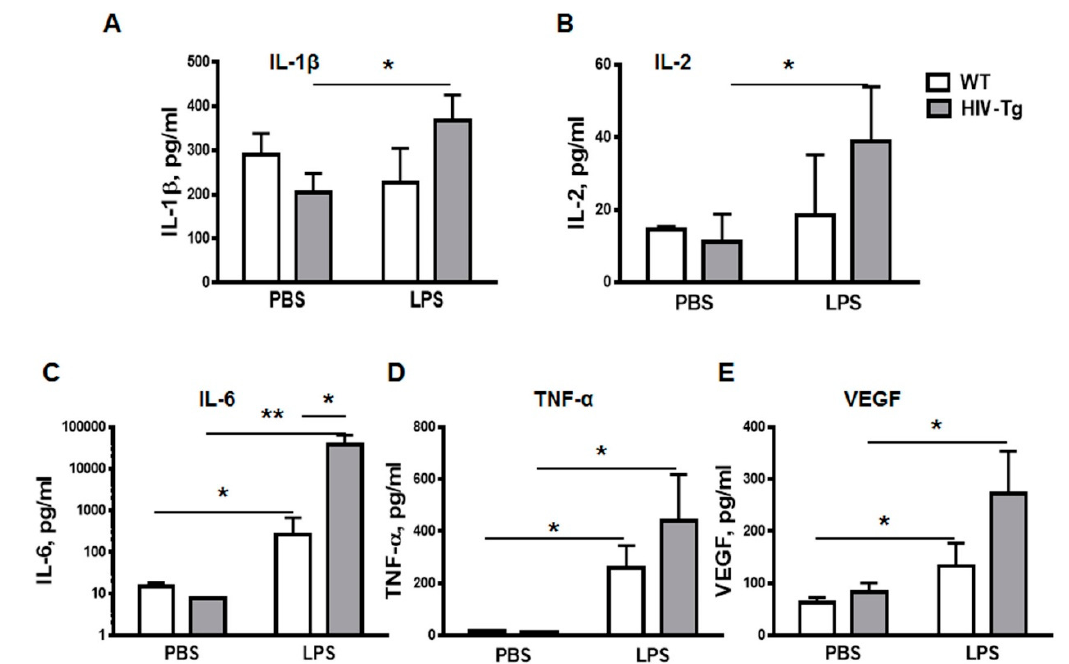
Figure 4. LPS-induced systemic pro-inflammatory cytokines in WT and HIV-Tg mice. Levels of circulating cytokines were measured by multiplex suspension array at 24 h after PBS and LPS administration. ( A ) IL-1 β , ( B ) IL-2, ( C ) IL-6, ( D ) TNF- α . ( E ) Levels of circulating VEGF were measured by enzyme-linked immunosorbent assay (ELISA). Asterisks indicate: * p < 0.05 and ** p < 0.01.